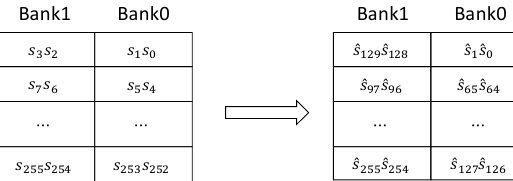
Figure 5: Detailed RAM structure, the left exhibits specific content after samples are written into the RAM and the right corresponds to results after NTT